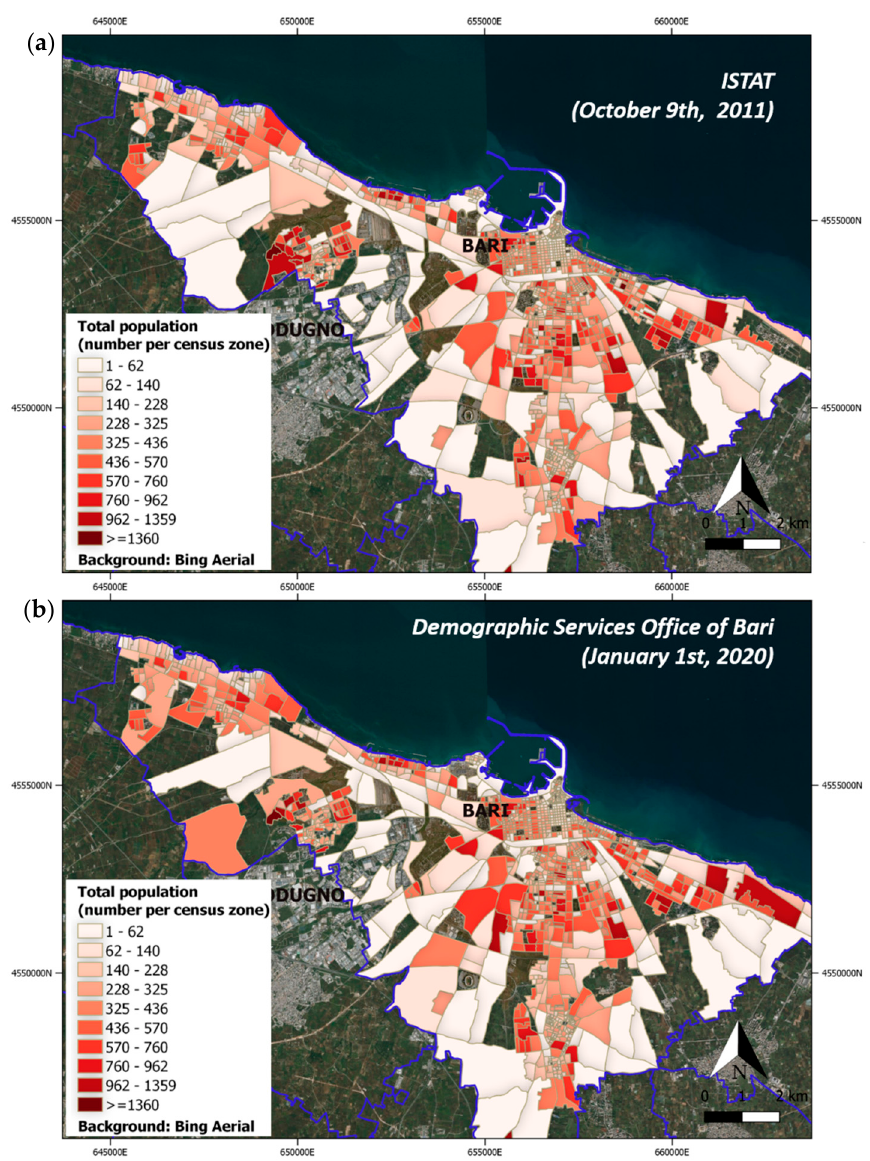
Figure 2. The total population per census zone of Bari in 2011 ( a ) and 2020 ( b ). Background source: Bing Aerial.